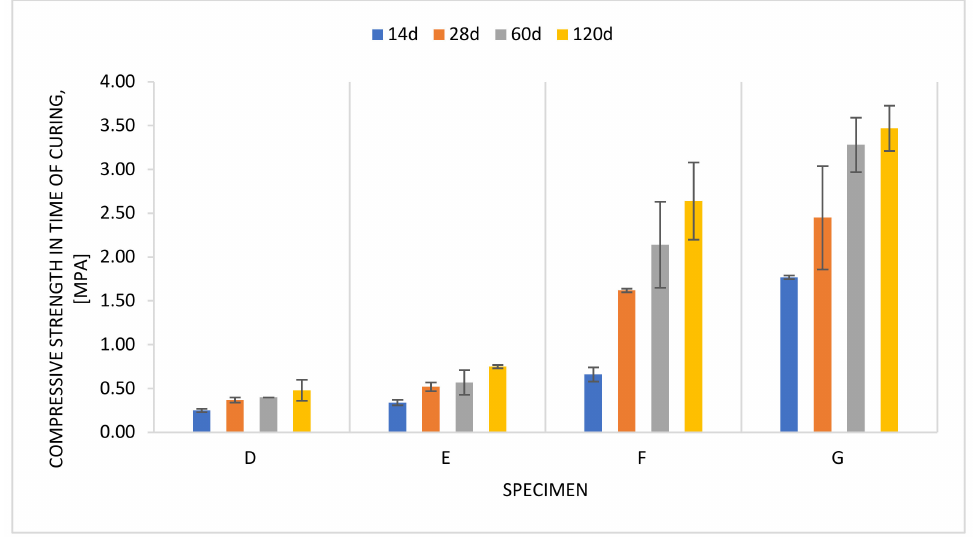
Figure 7. Compressive strength of slurries D–G in the course of